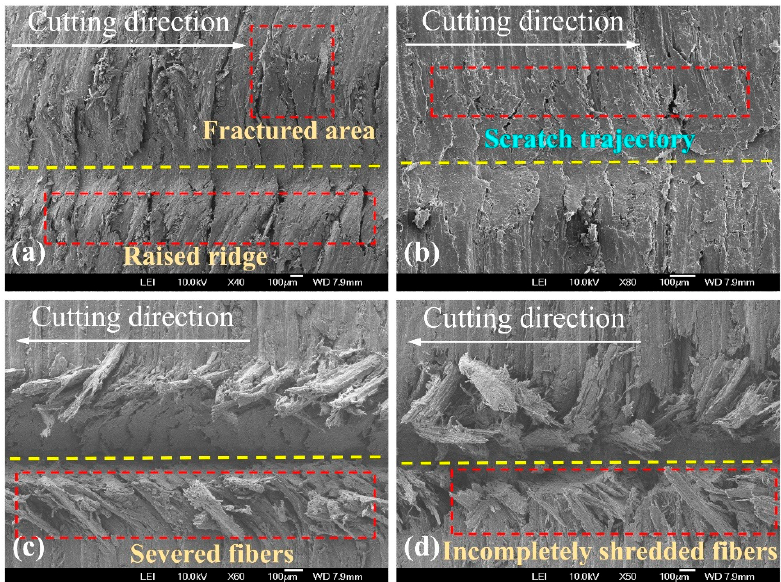
Figure 9. SEM micrographs of typical scratches ( λ = 90 ◦ ) cut by: ( a ) spherical cone tool with 2 α = 84 ◦ , ( b ) spherical cone tool with 2 α = 108 ◦ , ( c ) triangular pyramid tool with one main cutting edge and two side cutting edges, and ( d ) triangular pyramid tool with two main cutting edges.